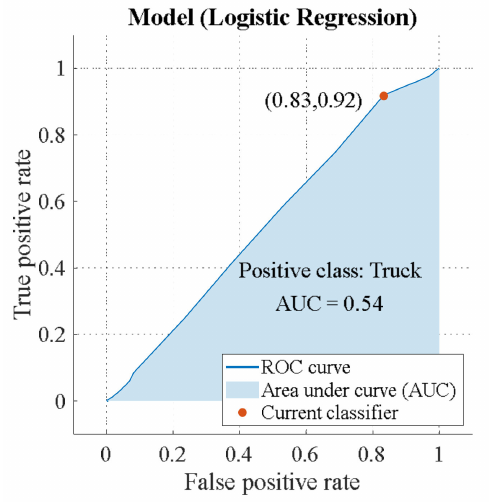
Figure 15. ROC of circular polarization (class